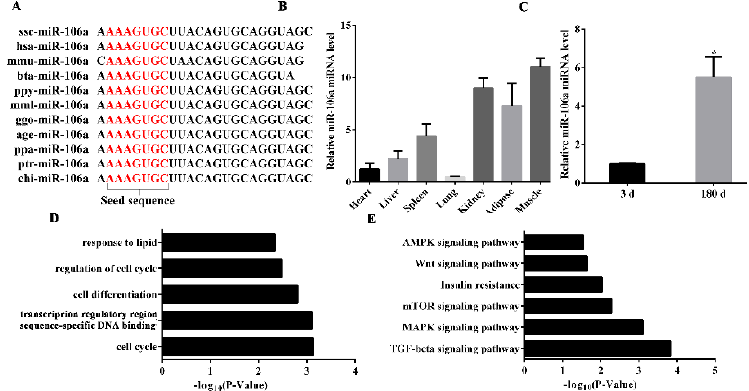
Figure 1. The expression level of miR-106a in different porcine tissues and a bioinformatics analysis of miR-106a. (A) The seed sequence of miR-106a is highly conserved across species; (B) miR-106a expression in seven different tissues of 180-day old Guanzhong black pigs; (C) miR-106a expression in the adipose tissue of 3-day and 180-day Guanzhong black pigs; (D) gene ontology (GO) term analysis of the miR-106a targets; (E) Kyoto encyclopedia of genes and genomes (KEGG) pathway analysis of the miR-106a targets. Data are representative of the mean ± SEM; n = 4. * p < 0.05, ** p < 0.01.